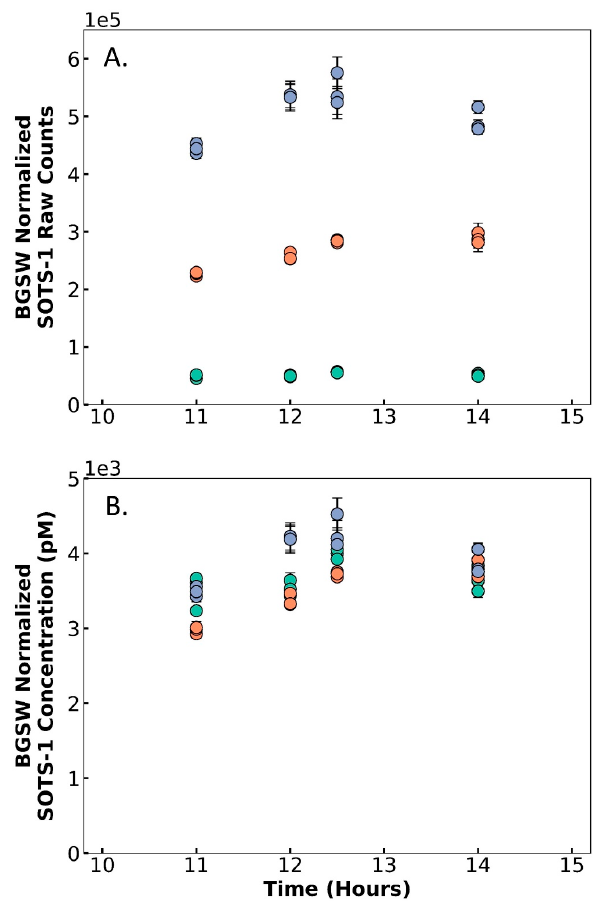
Figure 5. Results from multiple laboratory tests using SOTS-1 across time (x-axis, hours since SOTS-1 was mixed), showing ( A ) background seawater (BGSW)-normalized raw counts of SOTS-1 and ( B ) BGSW-normalized concentration of SOTS-1 (pM). Tests were completed using default voltage and different integration times: 100 ms (green), 500 ms (orange), and 900 ms (blue). Points represent the average signal and error bars represent the standard deviation.